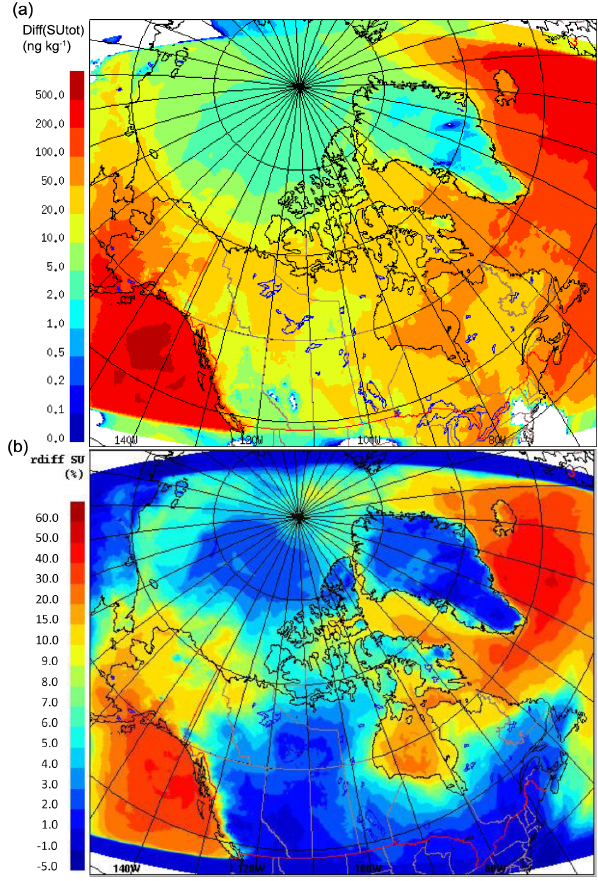
Figure 12. The absolute increment (a) and relative (percentage) in- crement (b) to the modelled July-averaged SO 2 concentration due to adding DMS(g) in GEM-MACH.